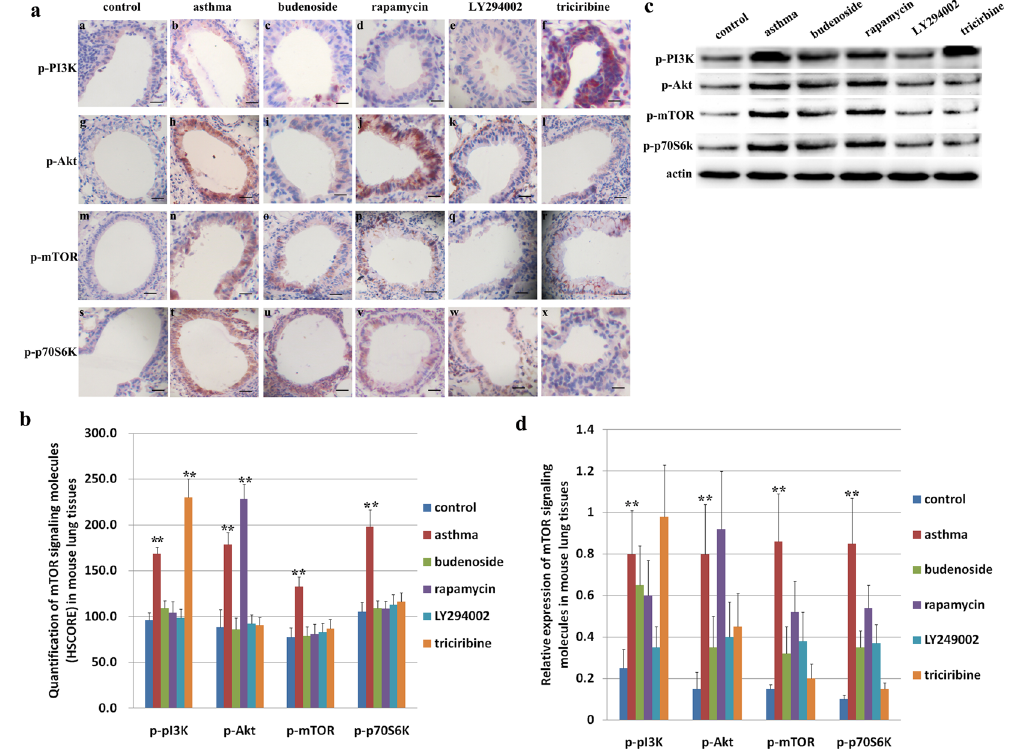
Figure 5. Activation of mTOR signaling molecules in the lung tissues of asthmatic mice and asthmatic mice treated with budenoside or mTOR pathway inhibitors. ( a ) IHC staining of mTOR signaling molecules of tissues from mice in the control group and the OVA-induced asthma group, and the OVA-induced asthmatic mice that were treated with budenoside, rapamycin, LY294002, or triciribine. All images were obtained at 200 × magnification. The scale bar represents 80 μ m. ( b ) Quantification of IHC staining (HSCORE) of mTOR signaling molecules from mice in the control group, the OVA-induced asthma group, and the OVA-induced asthmatic mice treated with budenoside, rapamycin, LY294002, or triciribine. The asthmatic mice demonstrated significantly higher levels of p-mTOR, and p-p70S6k than in the control, budenoside treatment, and m-TOR pathway inhibitor treatment groups. No statistical significance was observed among those groups. The level of p-PI3K in the asthmatic group and the triciribine-treated group were significantly higher than the rest of the groups. The level of p-Akt in the asthmatic group and the rapamycin-treated group were significantly higher than the rest of the groups. ( c ) Activation of mTOR signaling molecules determined by western blot in lung tissues from mice in the control group, the OVA-induced asthma group, and the OVA-induced asthmatic mice treated with budenoside, rapamycin, LY294002, or triciribine. ( d ) Quantification of mTOR signaling molecules by western blot normalized against the expression of β -actin. The asthmatic mice demonstrated significantly higher levels of p-mTOR, and p-p70S6k than in the control, budenoside treatment, and m-TOR pathway inhibitor treatment groups. No statistical significance was observed among those groups. The level of p-PI3K in the asthmatic group and the triciribine-treated group were significantly higher than the rest of the groups. The level of p-Akt in the asthmatic group and the rapamycin-treated group were significantly higher than the rest of the groups. All data was presented as the mean ± SD. * p < 0.05, ** p < 0.01, *** p <